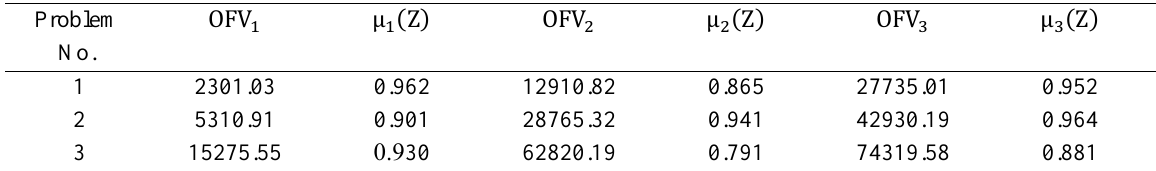
Table 3. Summary results of test problems by TH method for  = (0.5,0.2,0.3) and 𝝑 =0.6.